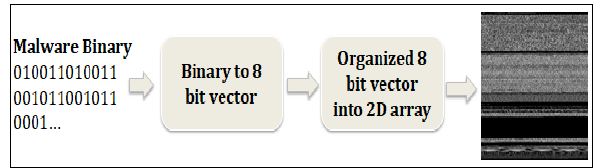
Figure 2. Visualizing malware as a grayscale image